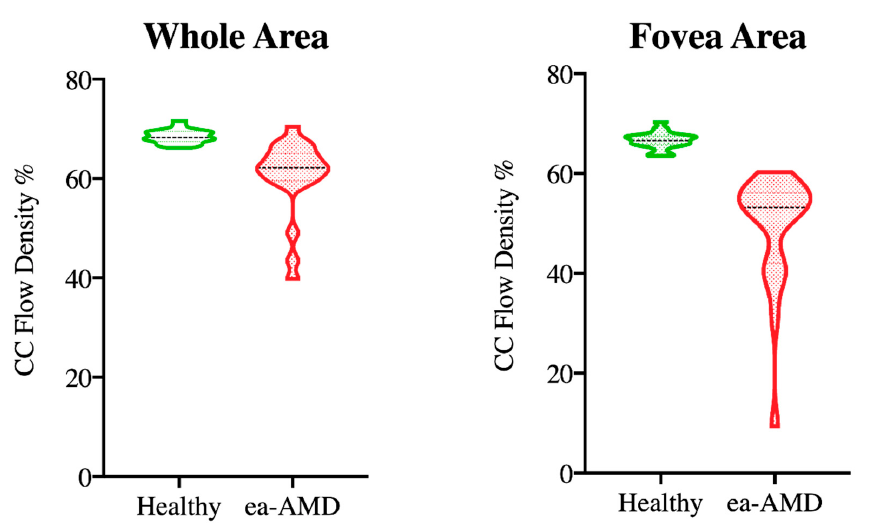
Figure 5. Violin plots show the comparison of choriocapillaris (CC) flow density (%) in healthy and in advanced exudative AMD (ae-AMD) eyes in the whole and fovea area assessed by OCT-Angiography. The plots show the median (black dashed line for heathy and for ae-AMD) and interquartile ranges (red and green lines). The differences were significant ( p < 0.0001) in both data sets.